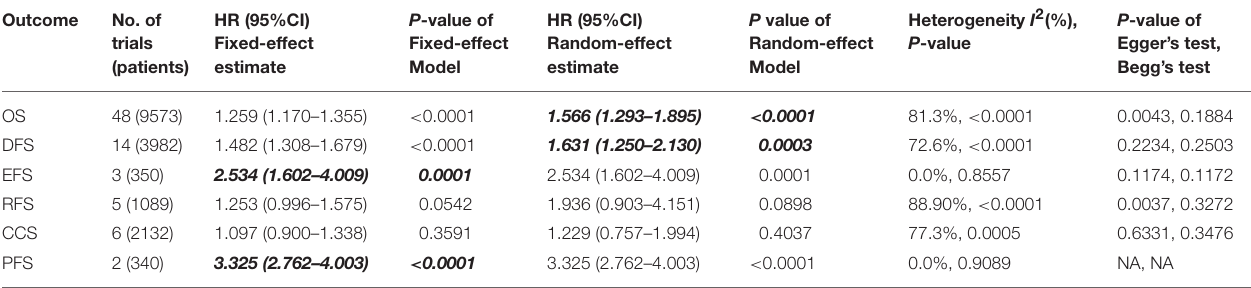
TABLE 2 | Survival effects of SIRT1 overexpression and the prognosis of patients. Outcome No. of